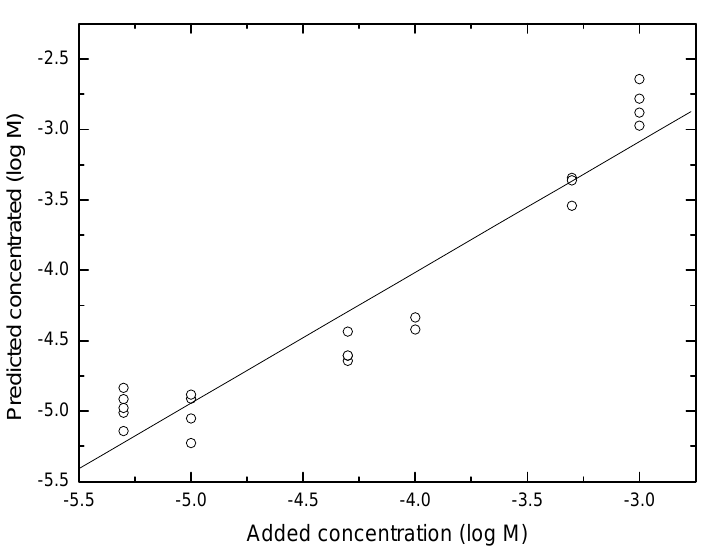
Figure 3. Calibration curve of ammonium from 5 × 10 -6 to 10 - 3 M at pH 6. PLS-1, full cross validation for 22 samples and two PCs were used and six electrodes were sufficient. Concentration of n-butyrate was below 10 -4